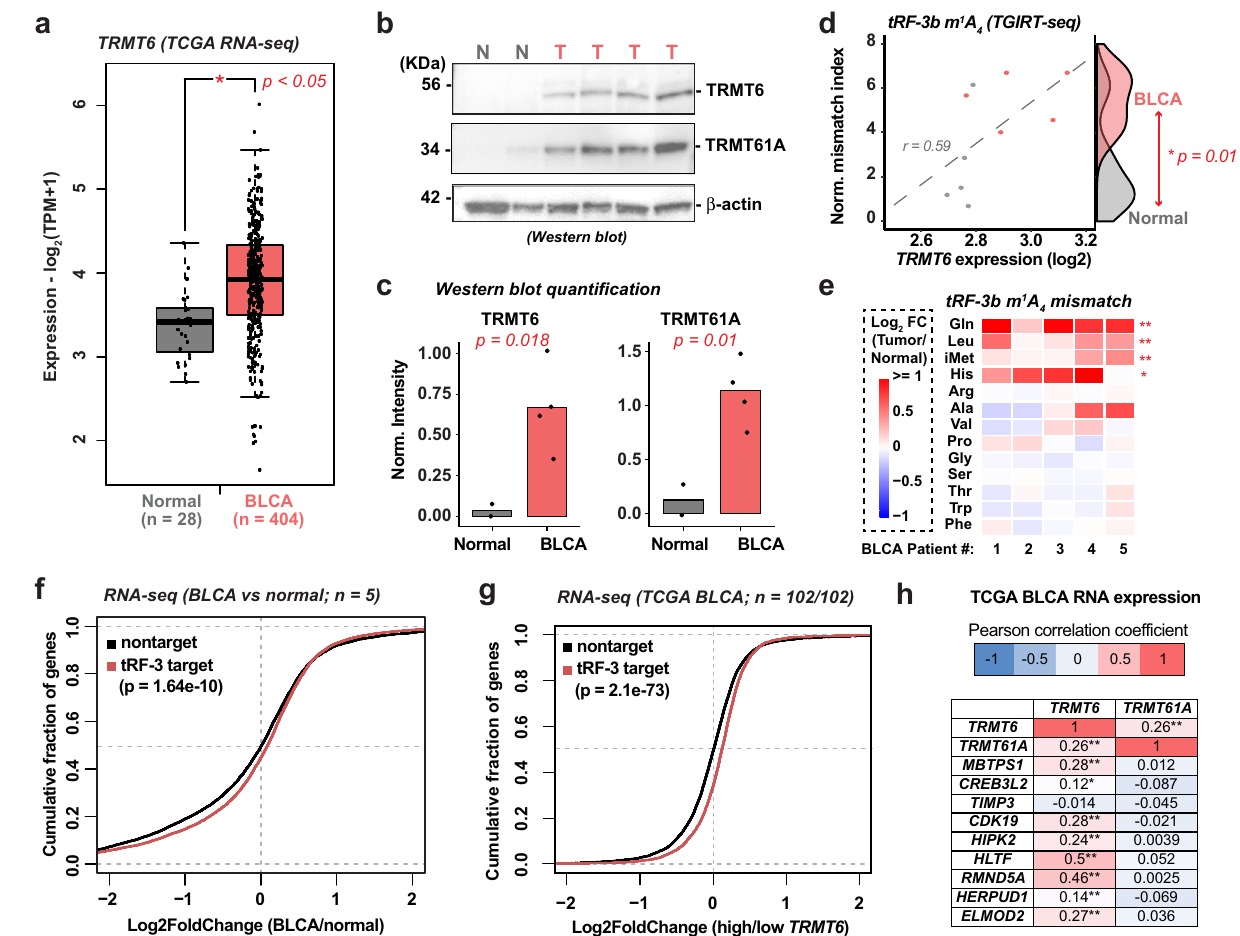
Fig. 7 Alteration of tRF-3 m 1 A levels and tRF-3 targets in bladder cancer. a TRMT6 expression in TCGA BLCA ( n = 404) compared to the normal ( n = 28, TCGA and GTEX). Expression ( Y -axis) is derived from RNA-seq on Log2 scale. Data visualized by GEPIA2 ( p value by one-way ANOVA). Boxplot center represents median, bounds represent 25 and 75%, and whiskers show the minimum or maximum no further than 1.5 * interquartile range from the bound. b , c TRMT6 and TRMT61A protein expression by Western blots in BLCA tumor versus normal samples, with β -actin as loading control. Relative protein expression is normalized to β -actin; p values based on two-tailed unpaired student ’ s t test. d , e m 1 A mismatch measured by TGIRT-seq in BLCA tumor samples and the paired normal ( n = 5). d Overall tRF-3b normalized mismatch index ( y -axis, index de fi ned by mismatch% over non-mismatch%) is plot against TRMT6 expression ( x -axis, log2 scale from RNA-seq). Signi fi cantly higher tRF-3b mismatch index is observed in tumors ( p value by paired student ’ s t test). e tRF-3b A4-mismatch% is compared between tumor and paired normal for each patient (red color in heatmap suggests higher mismatch % in tumor, p value by unpaired two-sided Wilcoxon test). f , g Global de-repression of tRF-3b targets observed in BLCA tumor compared to the paired normal ( f , n = 5) or in high- TRMT6 expressed (upper quartile) BLCA tumor ( n = 102) compared to the low- TRMT6 expressed (bottom quartile) tumors (n = 102) in TCGA ( g ). CDF (Cumulative Distribution Function) p value is calculated by one-sided Kolmogorov – Smirnov test to compare overall distribution between tRF-3 targets versus non-targets. h Correlation between TRMT6/61A expression and tRF-3 targets in TCGA BLCA patients ( n = 404). Pearson correlation was based on mRNA expression levels in TPM (transcripts per million) by GEPIA2 (visualized on log2 scale). Correlation coef fi cient summarized by color (red = positive correlation, blue = negative correlation), p value from paired correlation test, * p < 0.05, ** p < 0.01. Exact p values from up to down: e 0.0075, 0.0075, 0.0075, 0.025, 0.12, 0.66, 0.66, 0.66, 0.0075, 0.65, 0.66, 0.12, and 0.66; h TRMT6 – 9.1e − 8, 7.8e − 9, 0.019, 0.78, 8,4e − Supplementary Table 6. Source data are provided as a Source Data fi